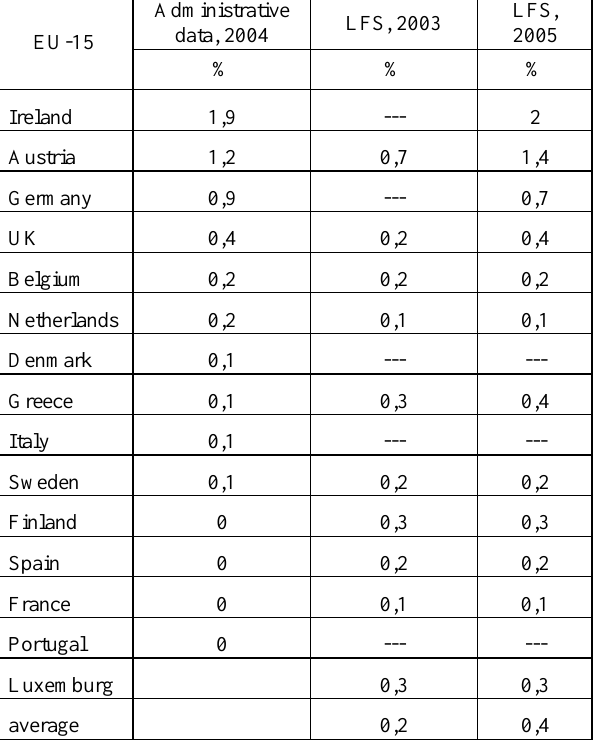
Table 6. EU-10 nationals as a percentage of EU-15